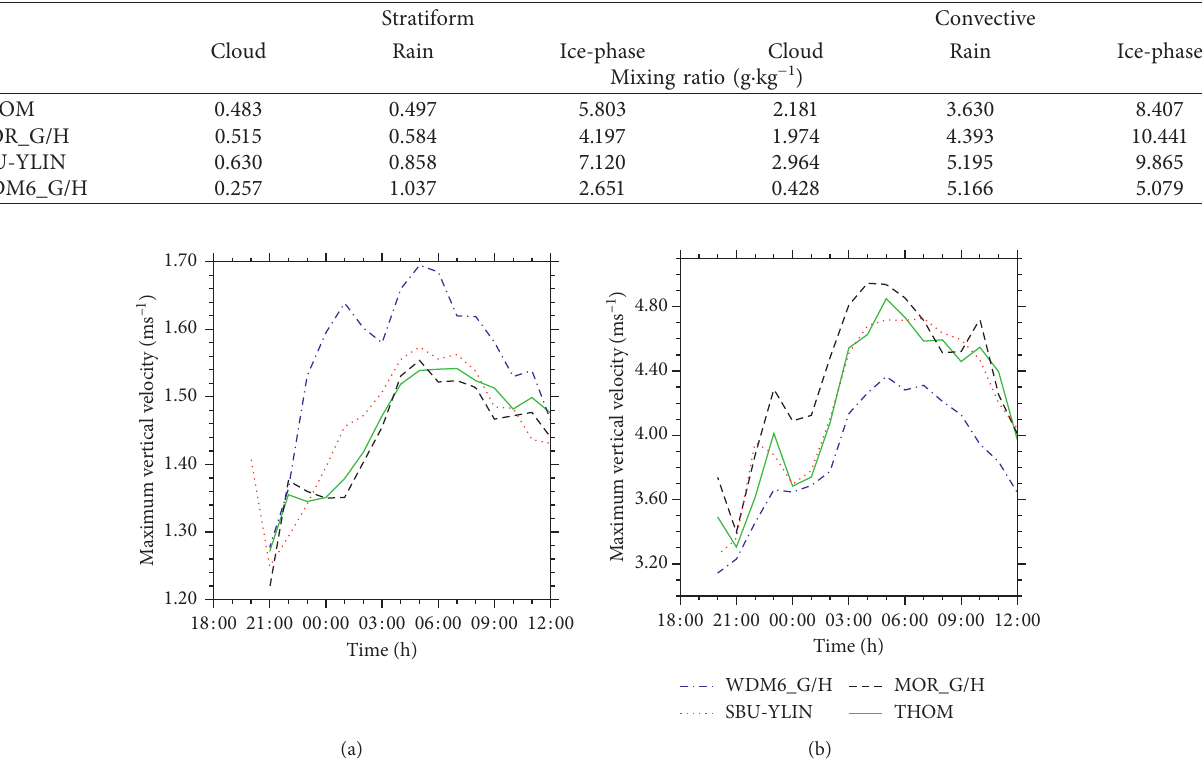
Figure 13: The temporal evolution of domain-averaged maximum vertical air velocity of THOM, MOR_G/H, SBU-YLIN, and WDM6_G/H scheme over (a) stratiform and (b) convective regions within the region (107–117 ° E, 27–35 ° N).